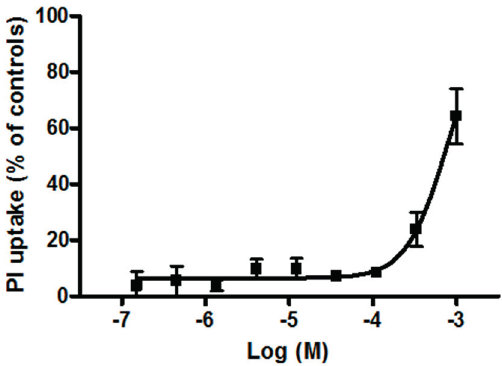
Figure 5. PI uptake in HaCaT cells exposed for seven days to TiO 2 NPs (1.5 × 10 (cid:3)7 –1.0 × 10 (cid:3)3 M). Data are reported as mean ± SE of three independent experiments